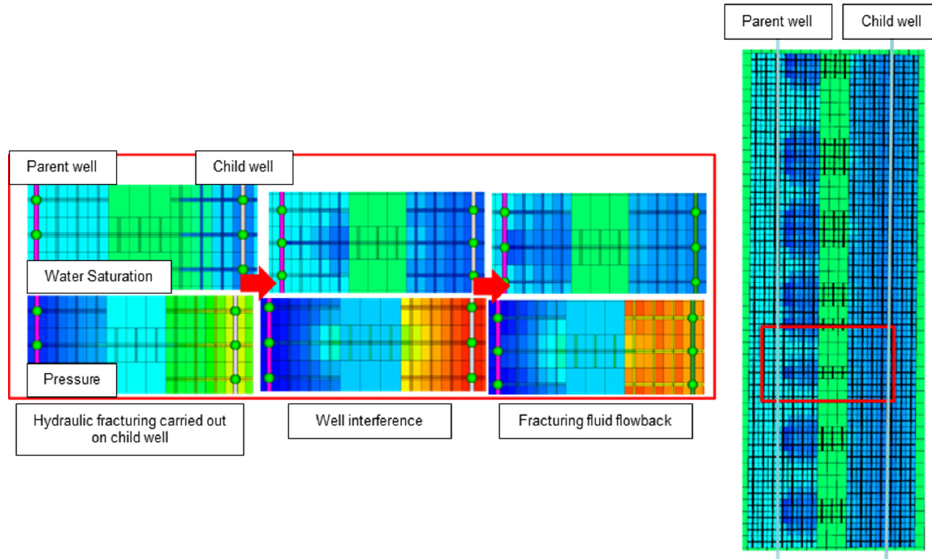
Figure 15. Water saturation and pressure distribution after well interference.